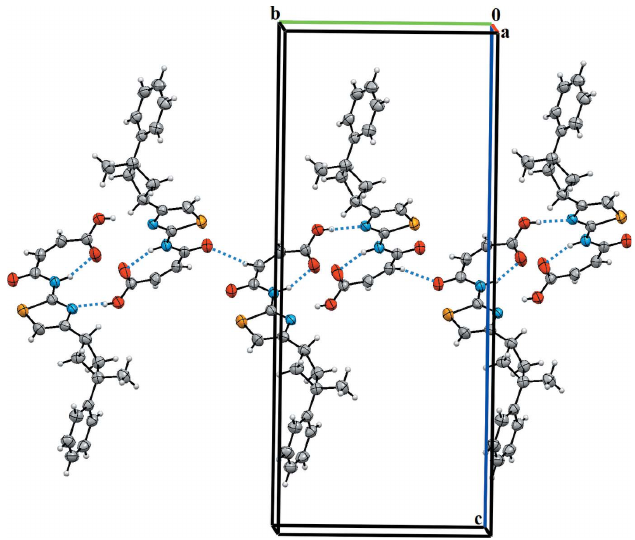
Figure 1 The molecular structure of the title compound with displacement ellipsoids drawn at the 40% probability level. Dashed lines denote the intramolecular N—H (cid:2)(cid:2)(cid:2) O hydrogen bonds forming an S 1